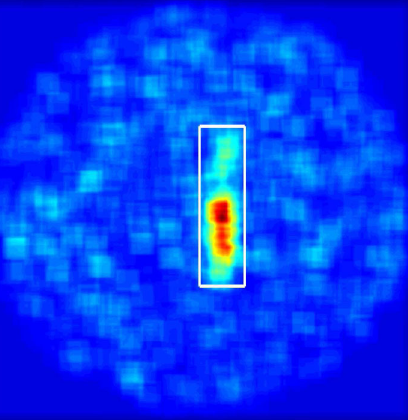
.FIG. 2. A single shot diffraction image taken at ’ ¼ 13 : 25 (cid:3) (8.6 keV), median filtered. The white box indicates the diffrac- tion pattern. The width (horizontal) of the x-ray distribution pattern is due to the slit acceptance while the vertical extent is determined by the Bragg